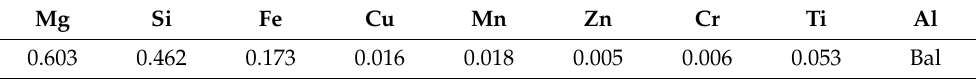
Table 2. Chemical composition of 6063 (weight fraction (%)).